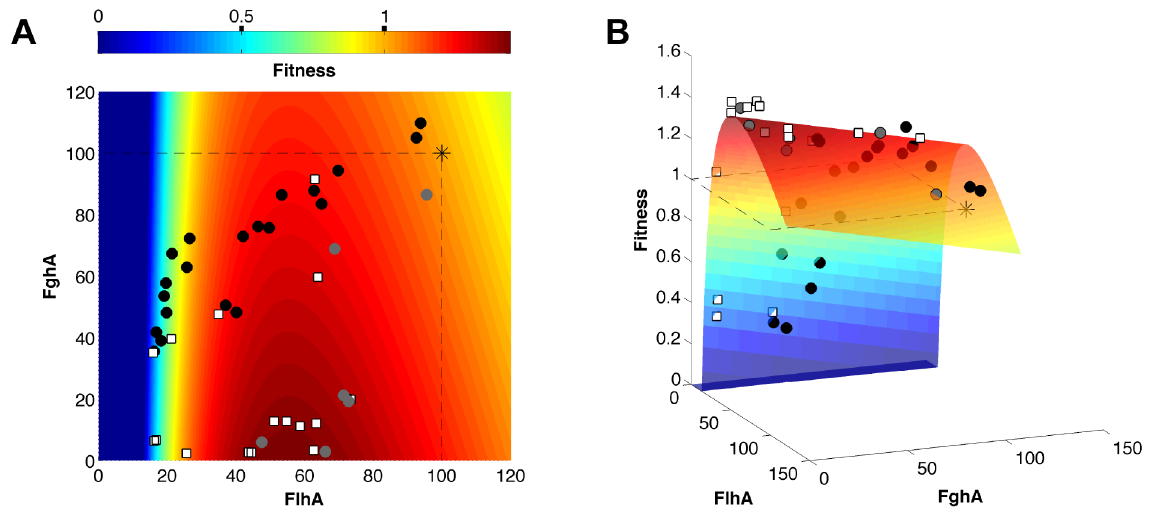
Figure 4. Fitness landscape of the GSH-linked pathway. A) A two-dimensional heatmap and B) three-dimensional surface showing the shape of the fitness landscape predicted by the model. The x and y axes are FlhA and FghA levels relative to ancestor (set at 100). Though the plasmid cost is included in the model, this fourth dimension was corrected for to allow a three-dimensional visualization (see Methods). Experimental data points indicate the ancestor (asterisk), single mutants (grey circles), mutational combinations (white squares), and inducible expression vectors (black circles).